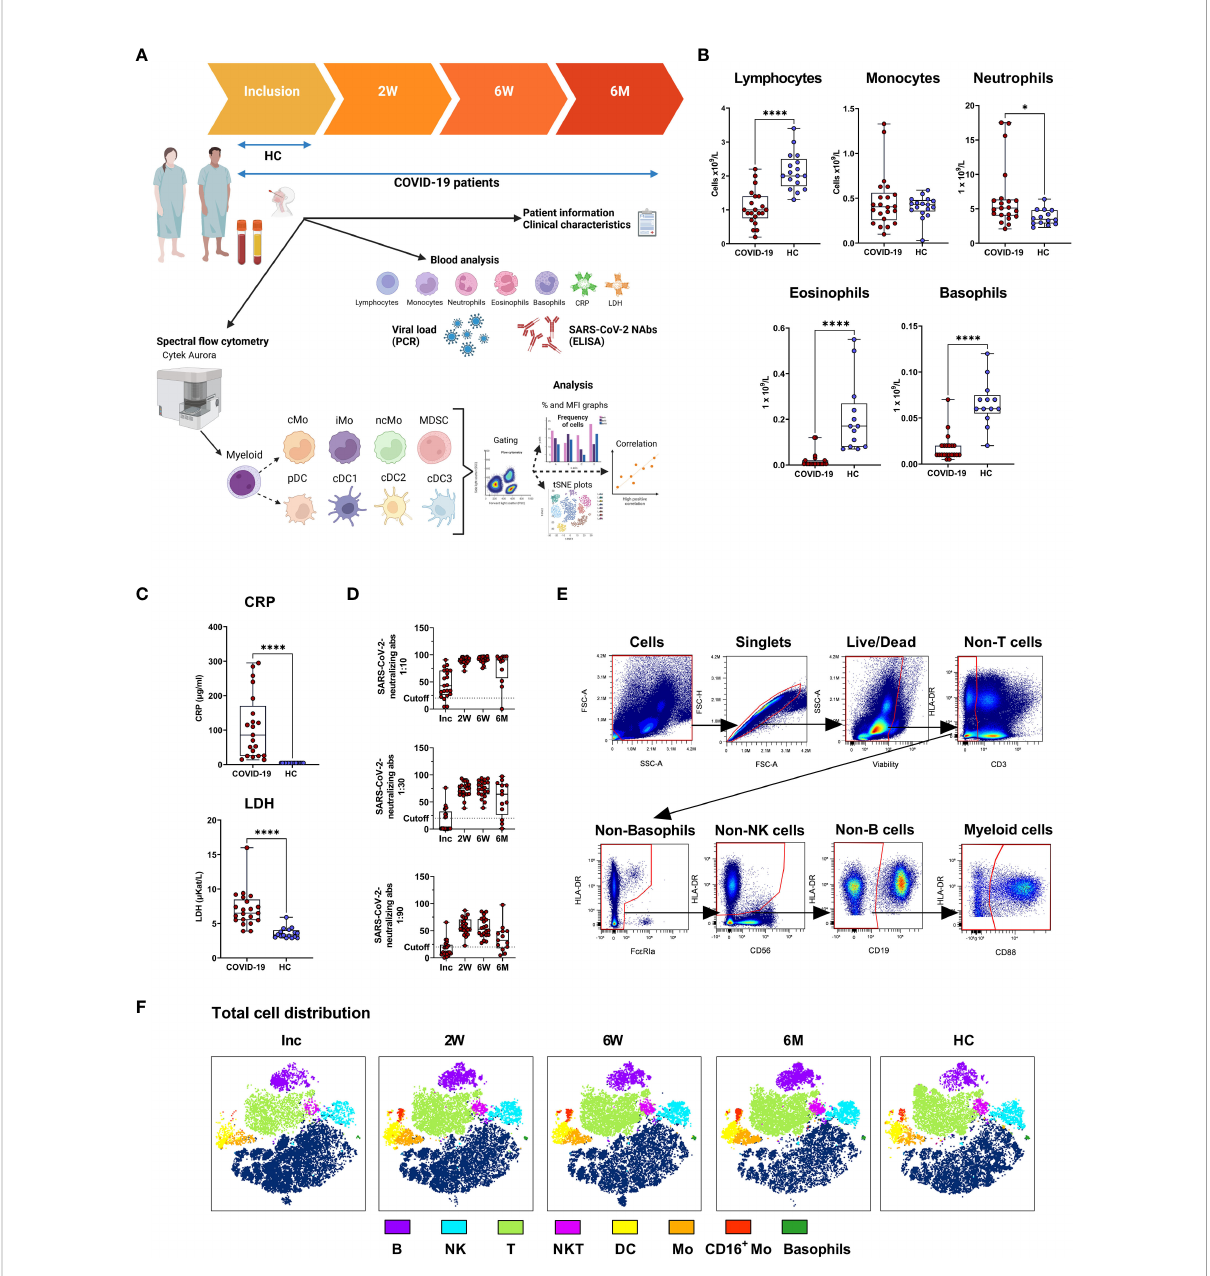
FIGURE 1 Study outline and experimental design. PBMCs and serum were collected from 21 COVID-19 patients and 16 healthy donors over a 6-7 month period. (A) Design of COVID cohort study illustrating timepoints for sample collection and experimental outputs, created with BioRender BioRender.com. Initial clinical assessments of (B) blood cell counts, (C) plasma C-reactive protein (CRP) and lactate dehydrogenase (LDH), and (D) neutralizing SARS-CoV-2 antibody titers. (E) Representative gating strategy to demonstrate live/dead gating and lineage exclusion, to leave myeloid cell populations for further analysis. (F) tSNE plots showing distinct clustering of all live cells, with 17 patients overlaid, and 16 controls overlaid. Data is represented as mean with 95% Cl, with signi fi cance of *p ≤ 0.05, ****p ≤ 0.0001, determined using Brown-Forsythe and Welch ANOVA tests. Inc, Study inclusion; 2W, 2 weeks; 6W, 6 weeks; 6M, 6-7 months; HC, healthy control. Mo, monocytes; cMo, classical; iMo, intermediate; ncMo, non-classical; MDSC, myeloid-derived suppressor cells; DC, dendritic cells; pDC, plasmacytoid; cDC1/2/3,